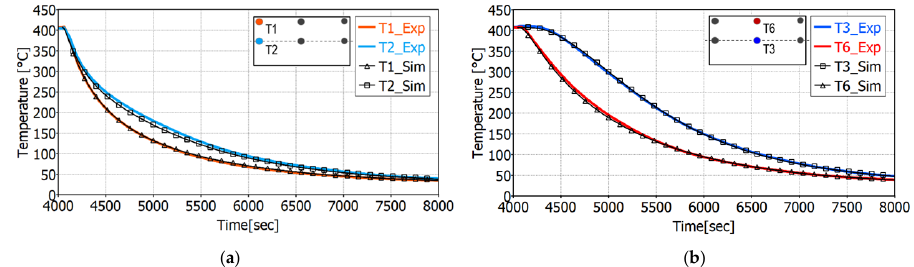
Figure 8. Temperature along the radial direction ( a ) in the face of the monolith (at 5 mm from inlet face) and ( b ) in the center of the monolith (at 63.5 mm from inlet face). Test 6-Tinit = 400 °C, Inclination = 0°. Figure 9 presents simulation and experimental results for the temperature field in the face of the monolith for 2 tests performed at 0° and 90° inclination. The model captures the effect of inclination on the thermal profile of the monolith face, since the temperature variation created close to the periphery is accurately predicted (Figure 9a). The corre- sponding temperature variation in the center of the face is minimal, as presented in Figure 9b.